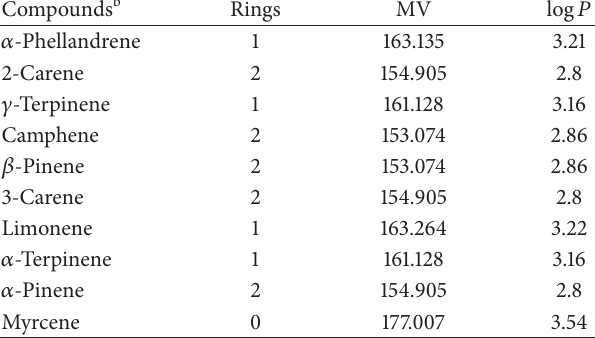
Table 5: Calculated molecular descriptors a for hydrocarbon com- pounds used in QSAR analysis of the fumigant efficacy against